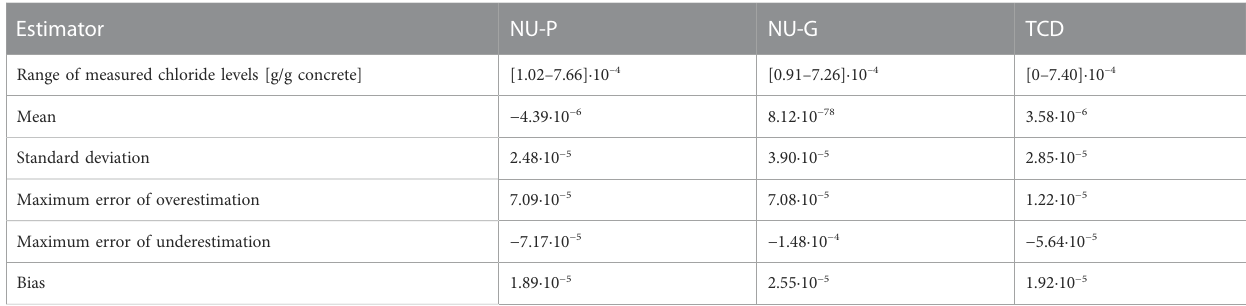
TABLE 2 Statistical estimators of measurement errors: case of series 1.